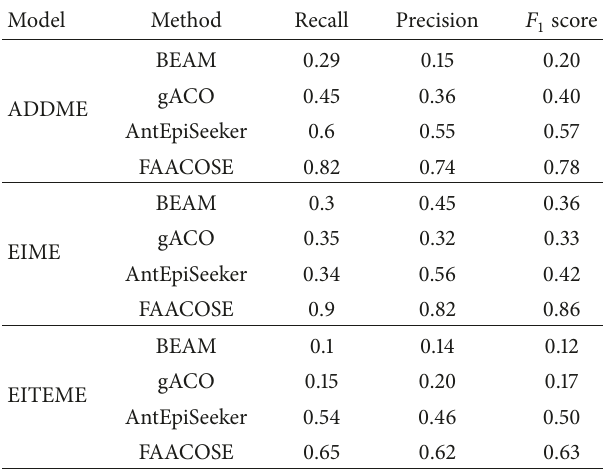
Table 2: The number of selected SNPs of FAACOSE in LOAD